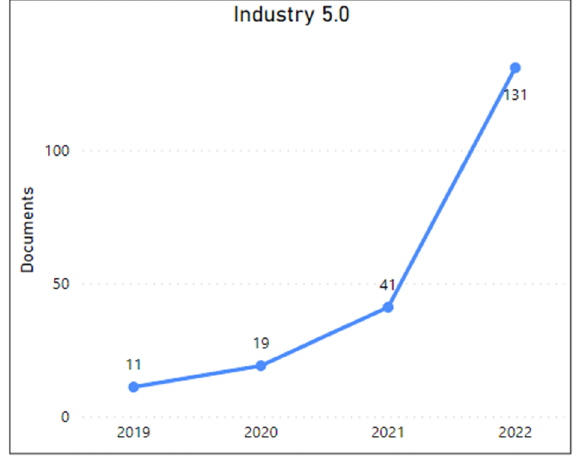
Figure 6. Industry 5.0—years 2006–2022. No data before 2019, 202 documents in period.